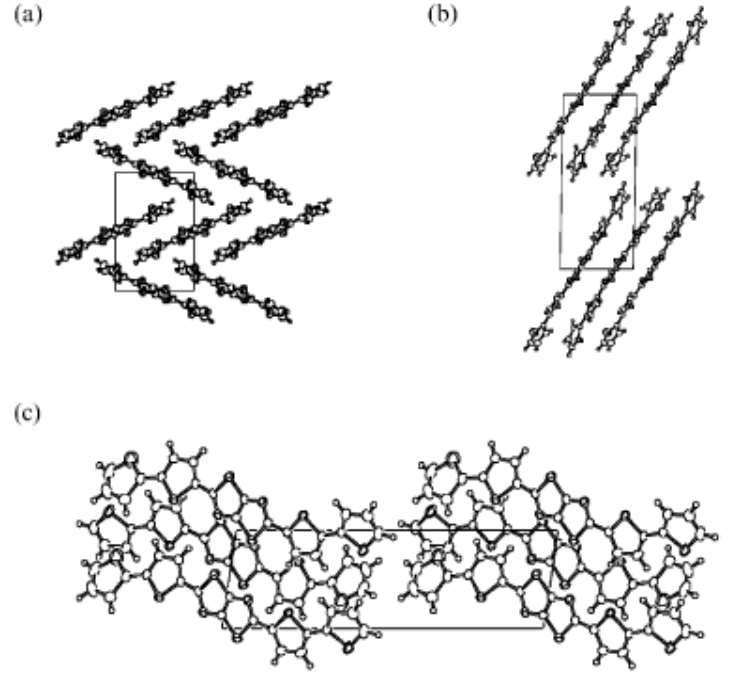
Figure 4. Packing view along the a -axis of TFZT (a), TTFZTT (b), and the b -axis of TTFZTT (c). From reference [48], DOI: 10.1039/b403699a. Reproduced by permission